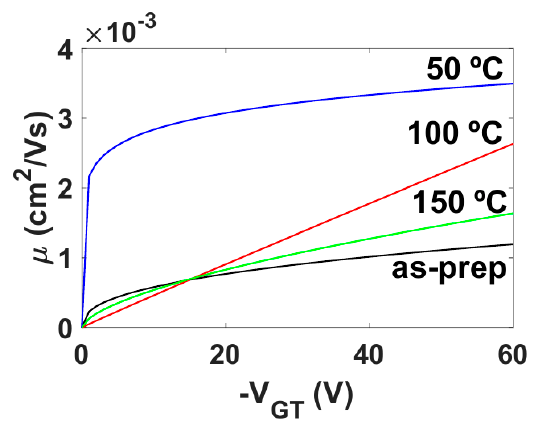
Figure 8. Mobility calculated using Equation (2) for different 𝑉 (cid:3008)(cid:3021) values at different annealing